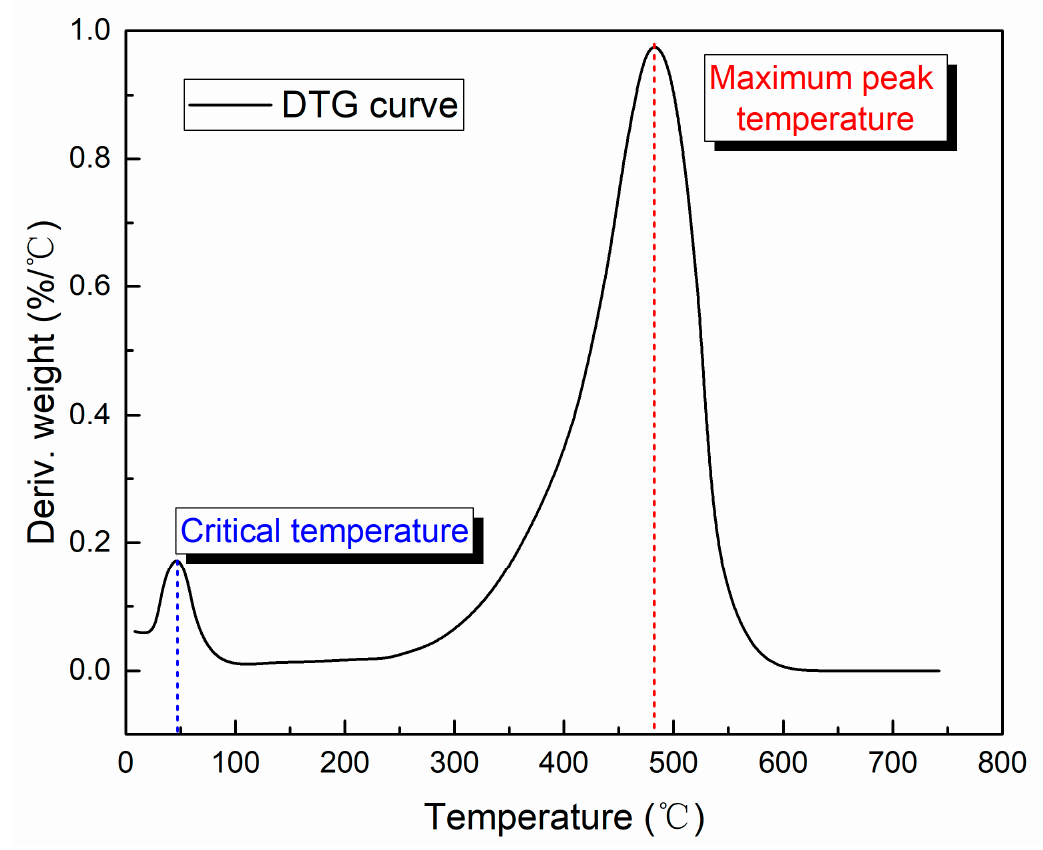
Figure 5. Definitions of critical temperature and maximum peak temperature.